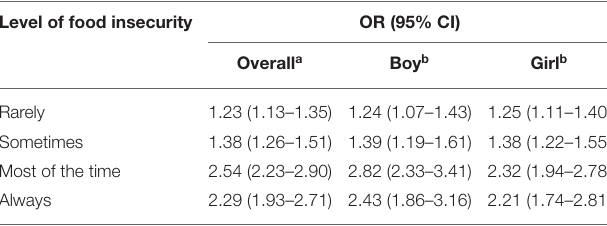
TABLE 2 | Association between food insecurity and sleep disturbance estimated by multivariable logistic regression (overall and by